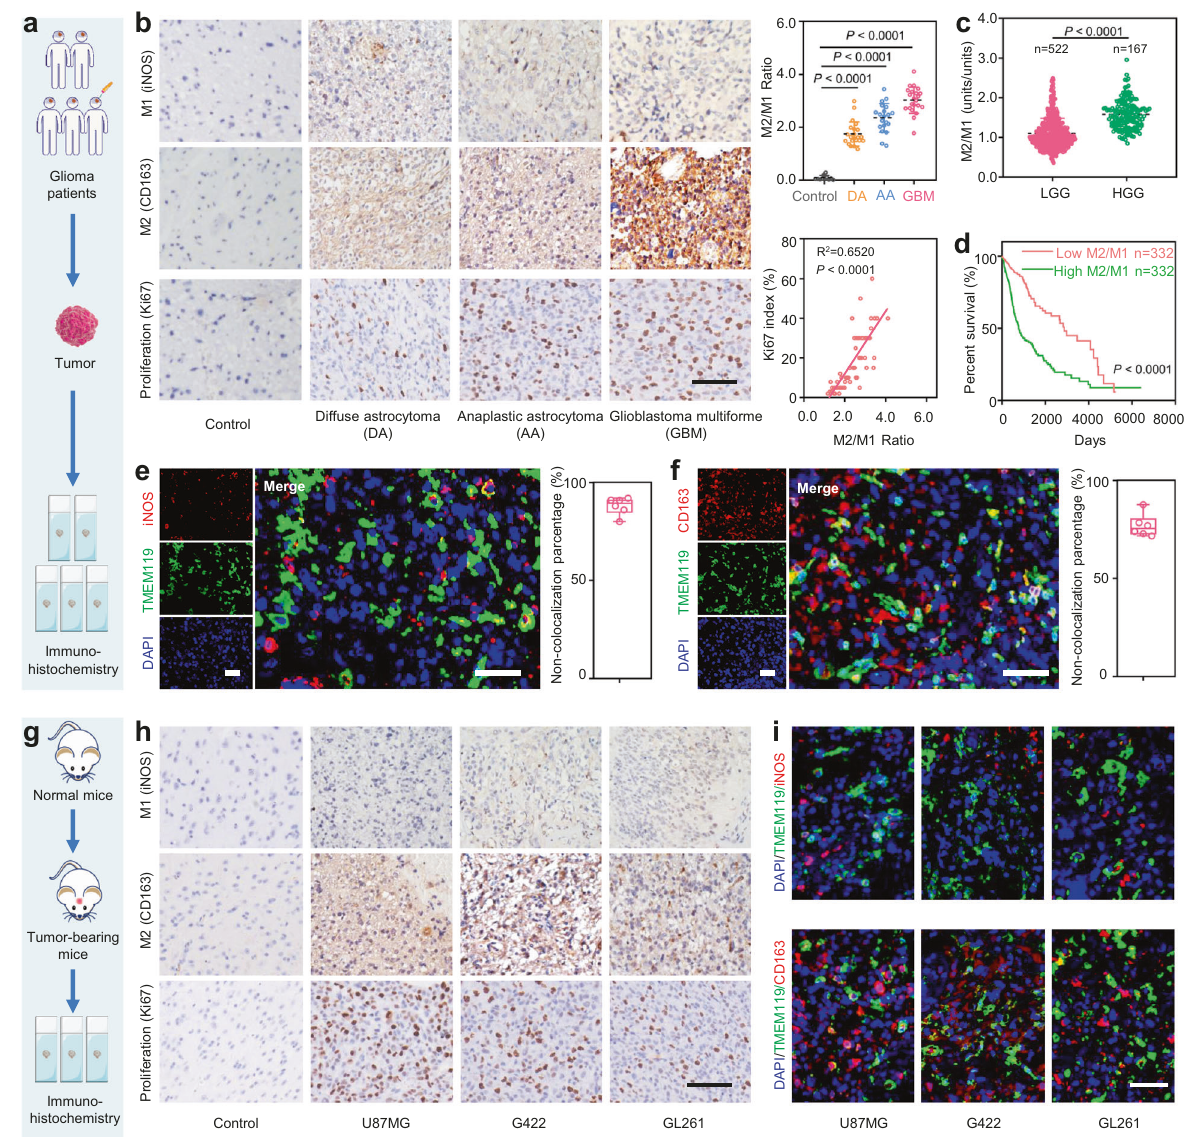
Fig. 1 Analysis of diverse gliomas obtained from patients and mice revealed distinct TAMs phenotypes and their origination. a . Schematic illustration of TAMs phenotype analysis from tumor samples of glioma patients. b . M1 macrophage (iNOS), M2 macrophage (CD163), and proliferation (Ki67) immunostaining of histological sections of tumor-adjacent tissues as control and in both low-grade gliomas (LGG: diffuse astrocytoma, n = 22) and high-grade gliomas (HGG: anaplastic astrocytoma, n = 20; glioblastoma multiforme, n = 22) resected from glioma patients. Quantitative analysis of the corresponding M2/M1 ratios was shown on the right side. The proliferation-related Ki67 marker index was positively correlated with the M2/M1 ratio. All images have the same scale of 50 μ m. c . M2/M1 ratio analysis of 167 HGG and 522 LGG cases acquired from The Cancer Genome Atlas (TCGA) database. Each dot represented a single individual. d . Survival curves of glioma patients from TCGA database. The OncoLnc tool was used to explore the survival correlations for M2/M1 ratio data. e . Immunostaining of histological sections (left) and quantitative analysis (right) of noncolocalization percentage of microglia (TMEM119, green) and M1 macrophage (iNOS, red) of human glioma tissue. All images have the same scale of 50 μ m. Nuclei: DAPI, blue ( n = 6). f . Immunostaining of histological sections (left) and quantitative analysis (right) of noncolocalization percentage of microglia (TMEM119, green) and M2 macrophage (CD163, red) of human glioma tissue. All images have the same scale of 50 μ m. Nuclei: DAPI, blue ( n = 6). g . Schematic illustration of TAM phenotype analysis from tumor samples of U87MG (human glioblastoma cells) /G422 (mouse glioblastoma cells) /GL261 (mouse glioma cells)-cell-derived xenograft tumor-bearing mice. h . M1 macrophage (iNOS), M2 macrophage (CD163), and proliferation (Ki67) immunostaining of histological sections of normal tissue, U87MG, G422, and GL261-bearing tissue in mice. All images have the same scale of 50 μ m. i . Microglia (TMEM119, green) and M1 macrophage (iNOS, red) immunostaining of histological sections of U87MG, G422, and GL261- bearing tissue (Top). Microglia and M2 macrophage (CD163, red) immunostaining of histological sections of U87MG, G422, and GL261-bearing tissue (bottom). All images have the same scale of 50 μ m. Nuclei: DAPI, blue. Data in b , e , and f are presented as the mean ± S.D. Statistical signi fi cance was calculated via one-way ANOVA with a Tukey post hoc test ( b ) or unpaired two-tailed Student ’ s t -test ( c ) and survival analysis was calculated by two-sided Log-rank Mantel-Cox tests ( d )